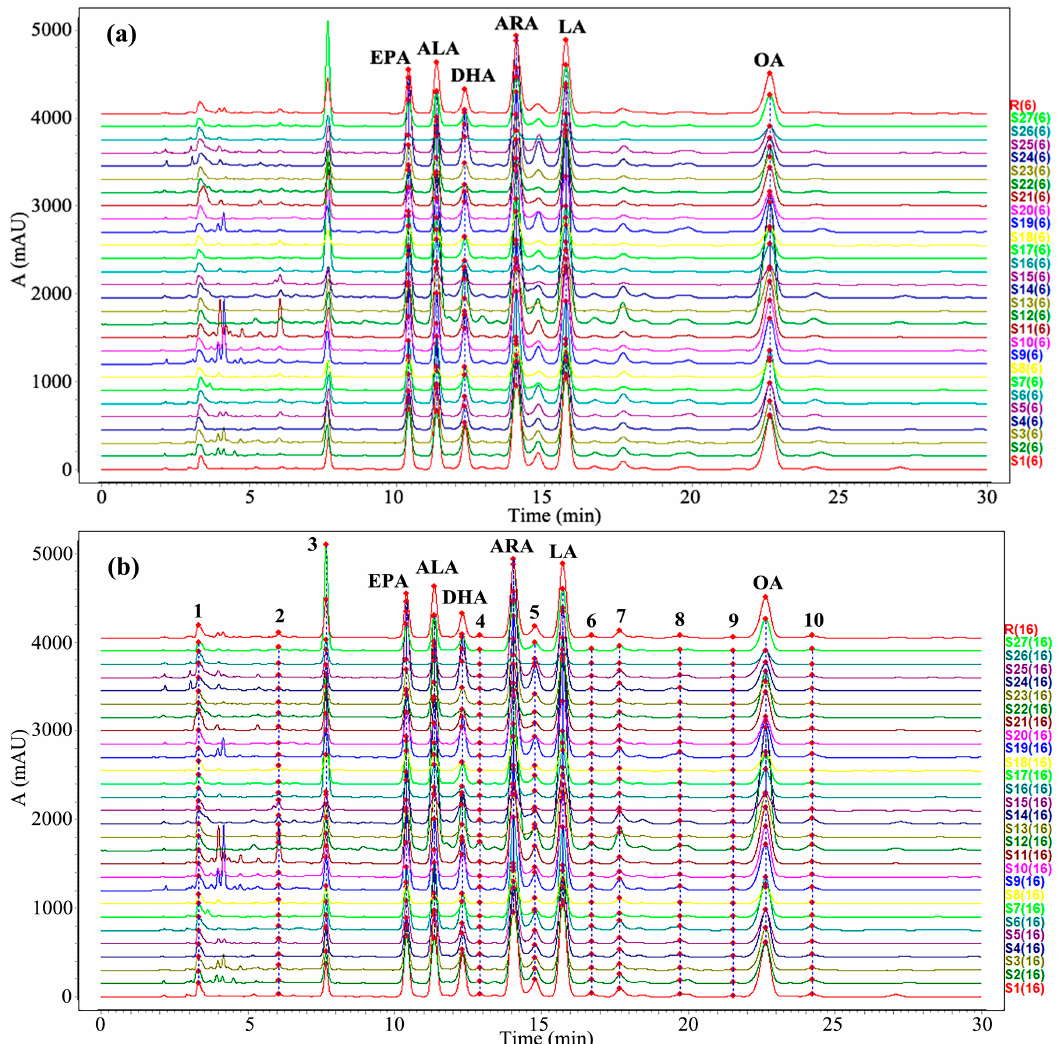
Figure 5. HPLC fingerprint chromatogram of 27 batches of Oviductus Ranae . ( a ) The fingerprint with six known PUFA peaks and ( b ) The fingerprint of 16 peaks with a peak area ratio greater than 0.5%.